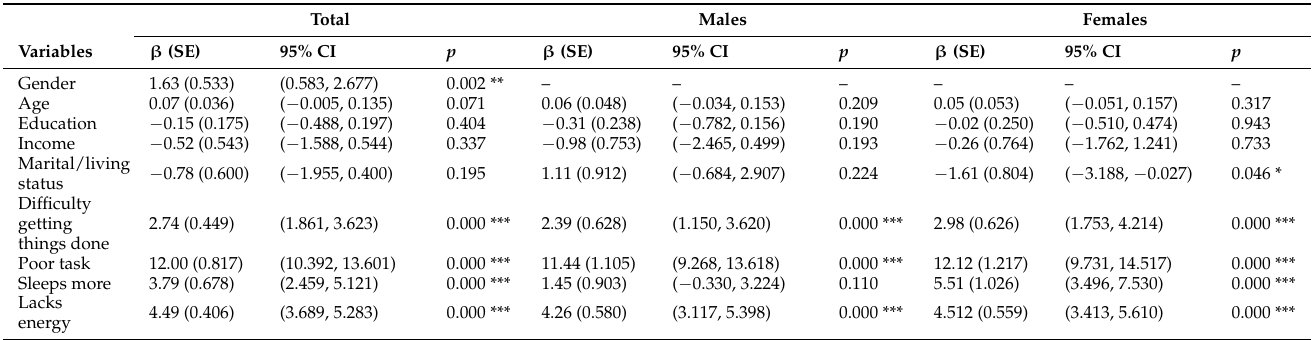
Table 3. Adjusted general linear regression for factors associated with SCD among old adults and in each gender